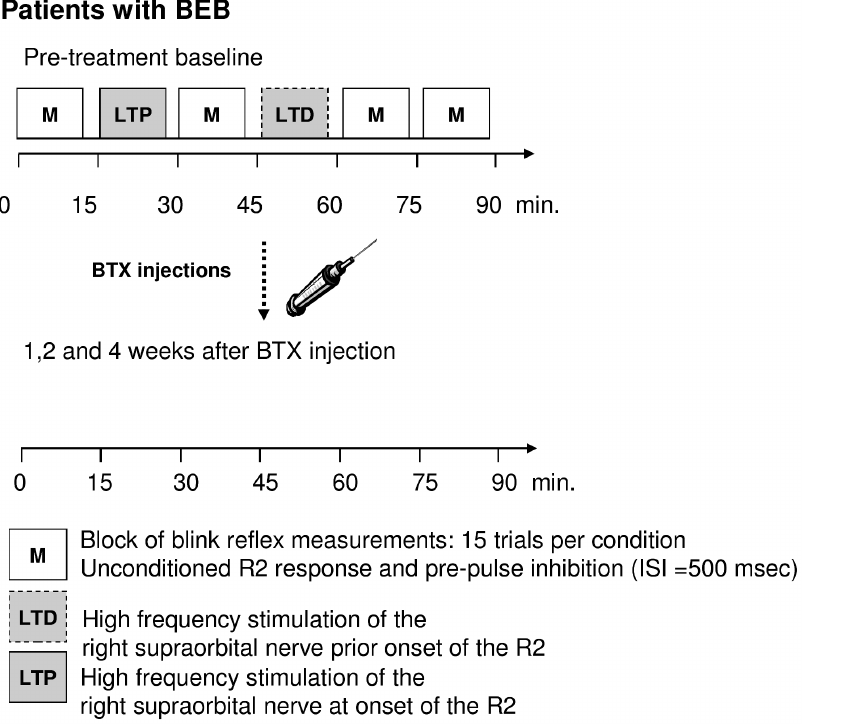
Figure 2. Probing the influence of BTX injections on homeostatic-like plasticity. HFS LTP-LTD before, one, two and four weeks after Botulinum toxin (BTX) treatment was investigated in patients with blepharospasm.